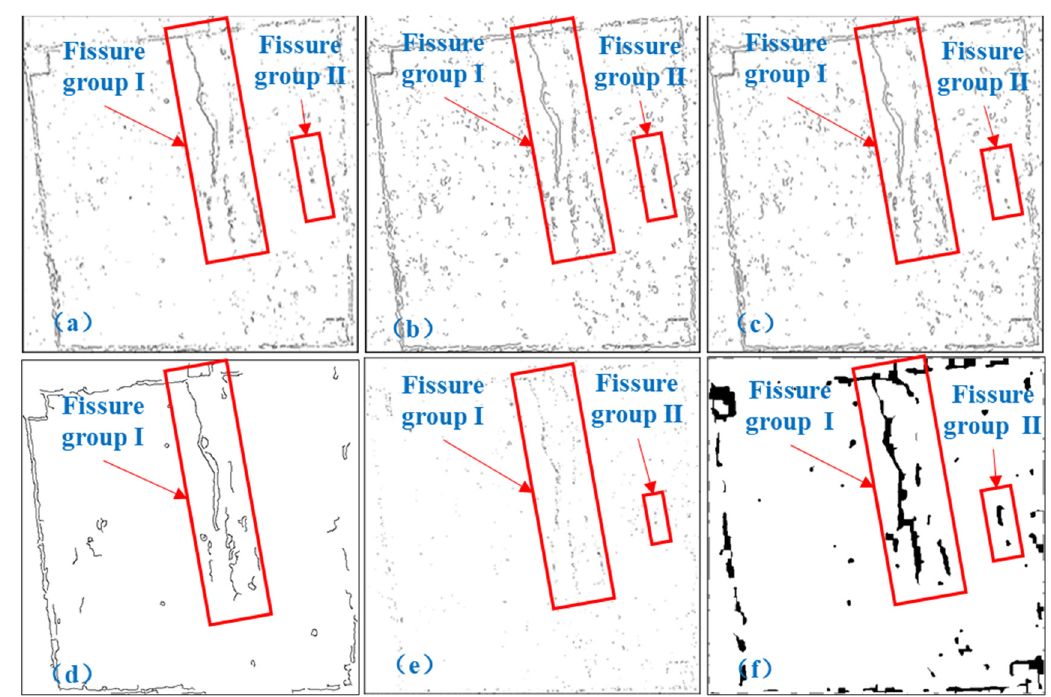
Figure 9. Results of mining-induced ground fissure detection using multiple edge detection methods for the fused image. ( a ) Roberts operator. ( b ) Sobel operator. ( c ) Prewitt operator. ( d ) Canny operator. ( e ) Laplacian operator. ( f ) Proposed method. Table 3. The evaluation indexes scores of multiple edge detection methods for the fused image.